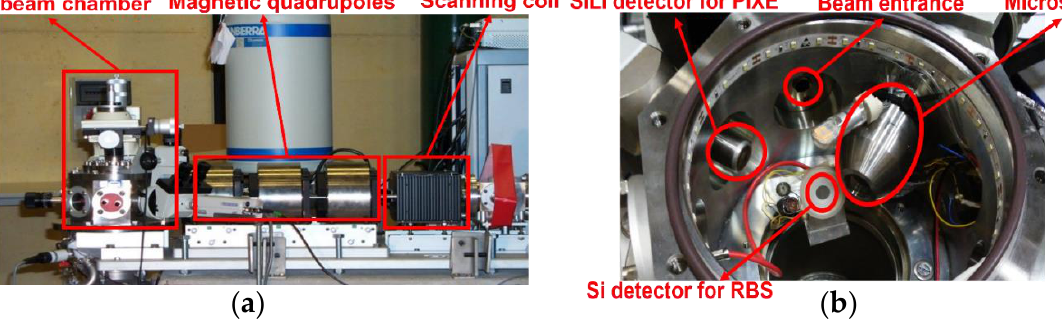
Figure 6. ( a ) Main elements of the microbeam system at CNA. ( b ) Zenithal image of the vacuum chamber into which the samples are